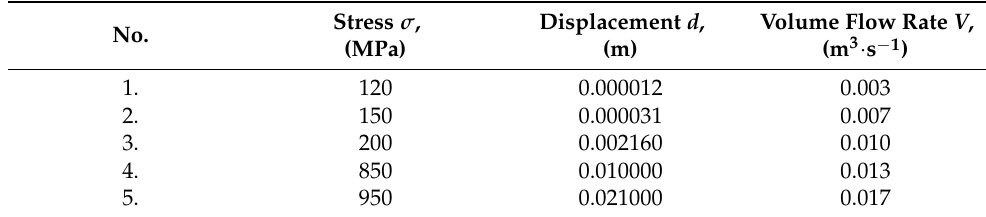
Table 1. Change of von Misses stress ( δ ) and displacement ( d ) depending on the volume flow rate of the fluid.